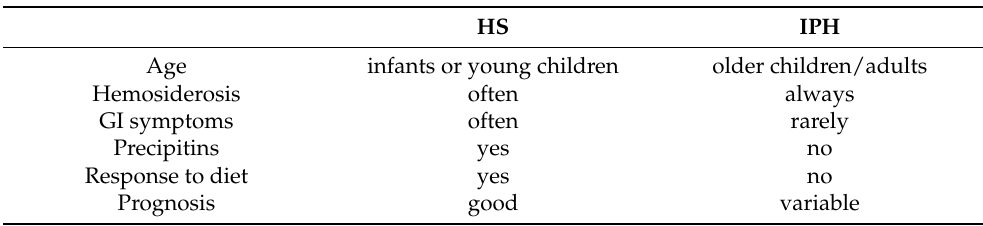
Table 2. Differential diagnosis between Heiner syndrome (HS) and idiopathic pulmonary hemosidero- sis